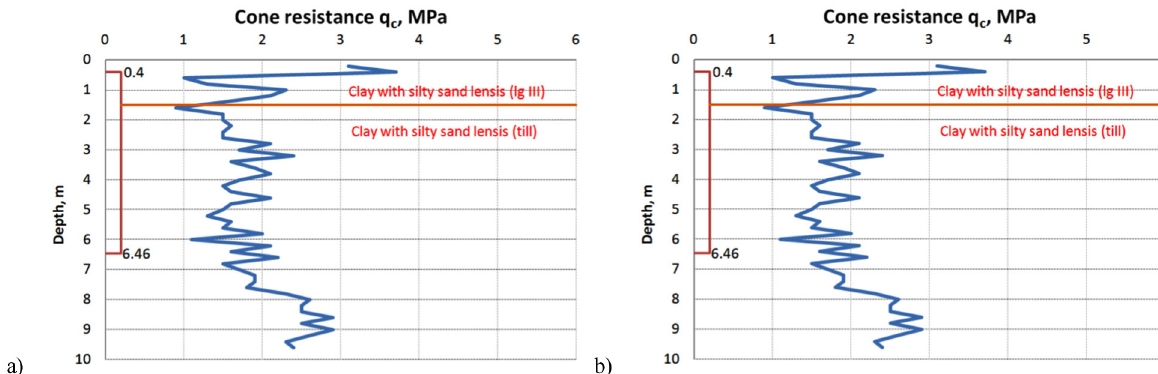
Fig. 2. Cone penetration test and borehole data: a – near the 1 st test pile, b – near the 2 nd test